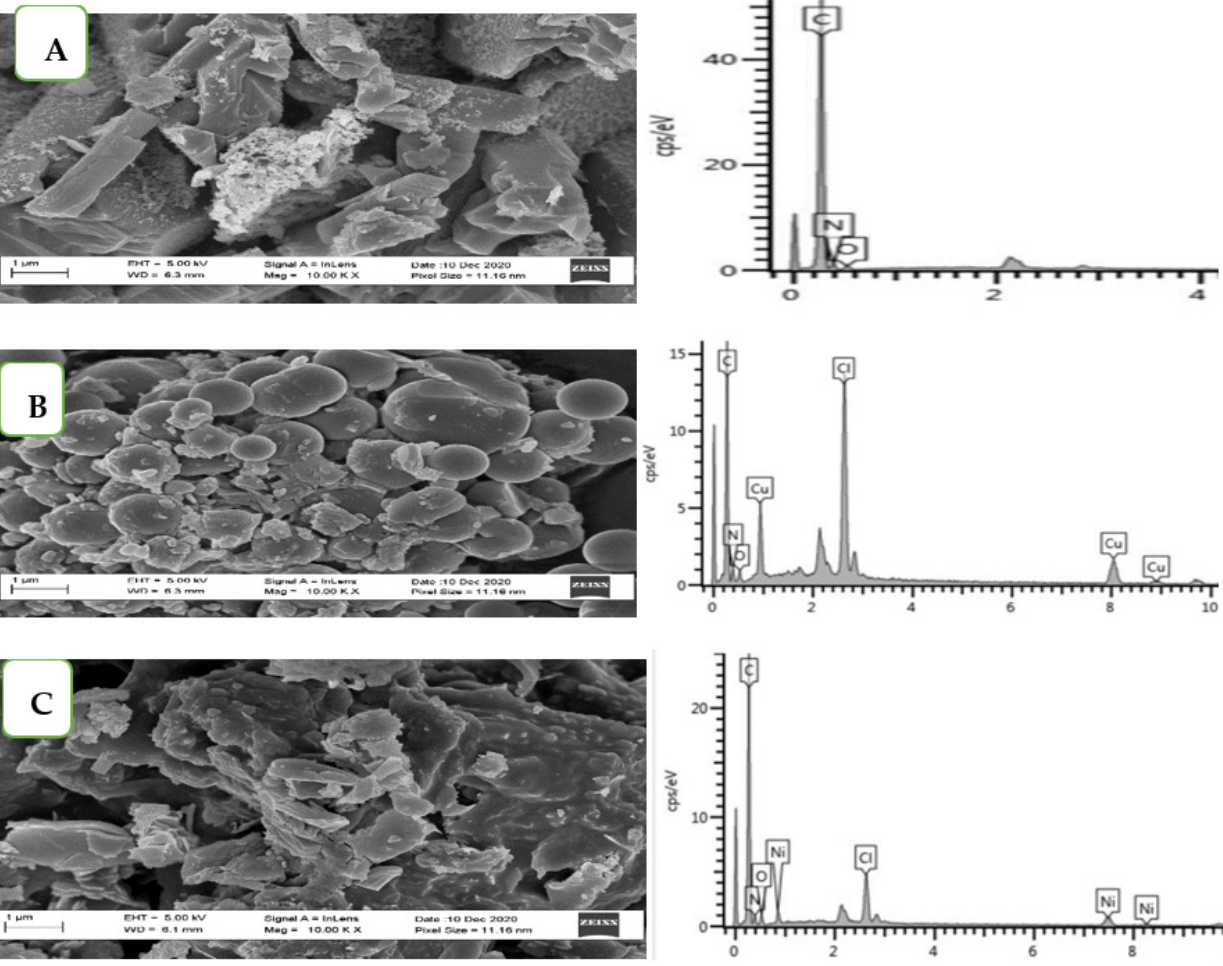
Figure 5. SEM micrographs of Schiff base ligand ( A ), Cu(II) complex ( B ), and Ni(II) complex ( C ) with their corresponding EDS spectra on each side. Each image was taken at a magnification of 10,000 × . In general, SEM images displayed irregular and heterogeneous surfaces for ligand and metal complexes. The images also revealed some changes in the morphology of